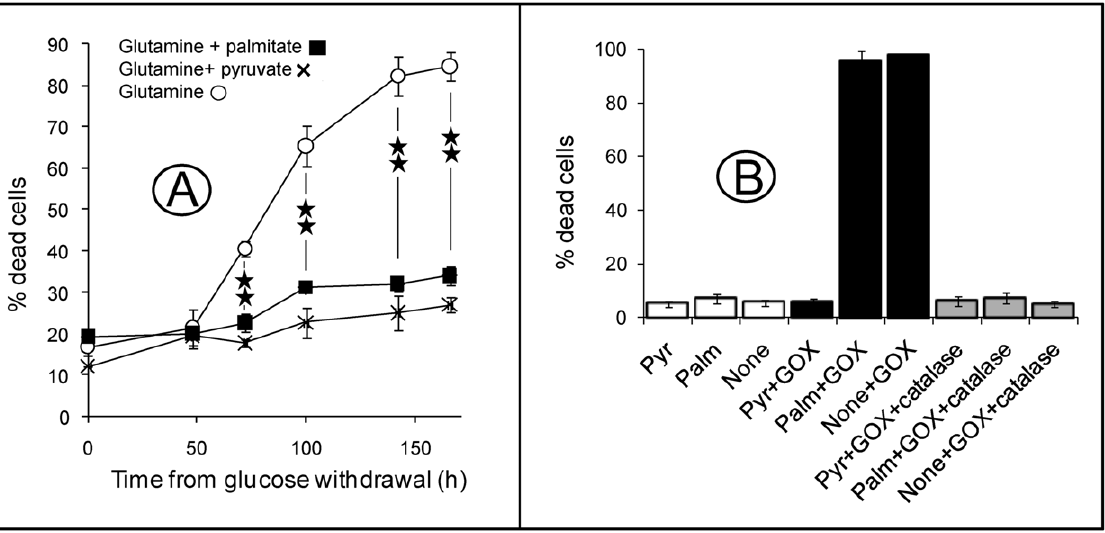
Figure 1. Protection from cell death triggered by either glucose withdrawal in patient 1 (P1) cells (A) or hydrogen peroxide addition in control cells (B) afforded by palmitate or pyruvate. A: In Patient 1 (P1) cells, death occurred within 72 hours after glucose withdrawal, when cells were cultured in the presence of glutamine (open circles). When cells were cultured in the presence of 100 m M palmitate (dark squares) or 2 mM pyruvate (crosses), these were significantly protected from death. B: Control cells were counted 24 hours after the addition of 2 mM pyruvate (Pyr) or 100 m M palmitate (Palm) in standard DMEM 4.5 g/L glucose, 4 mM glutamine medium (none) with or without 0.001 mg/mL glucose oxidase or glucose oxidase and 350 ng/mL catalase. Pyruvate but not palmitate protects against H 2 O 2 -induced cell death. Values are means 6 SEM from triplicate experiments. **: p , 0.01 (Student’s two-tailed t test). Experimental procedures as described under Materials and methods.